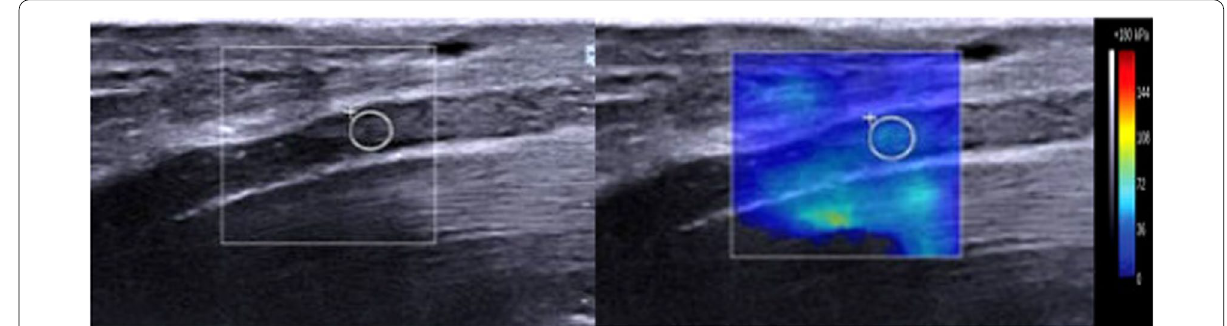
Fig. 7 A 40 years old female patient with clinical evidence of DPN. (Left) high resolution ultrasound showed thickened tibial nerve with increased CSA (18 mm 2 ). (Right) shear-wave elastography of the tibial nerve displayed increased mean tibial nerve stiffness value